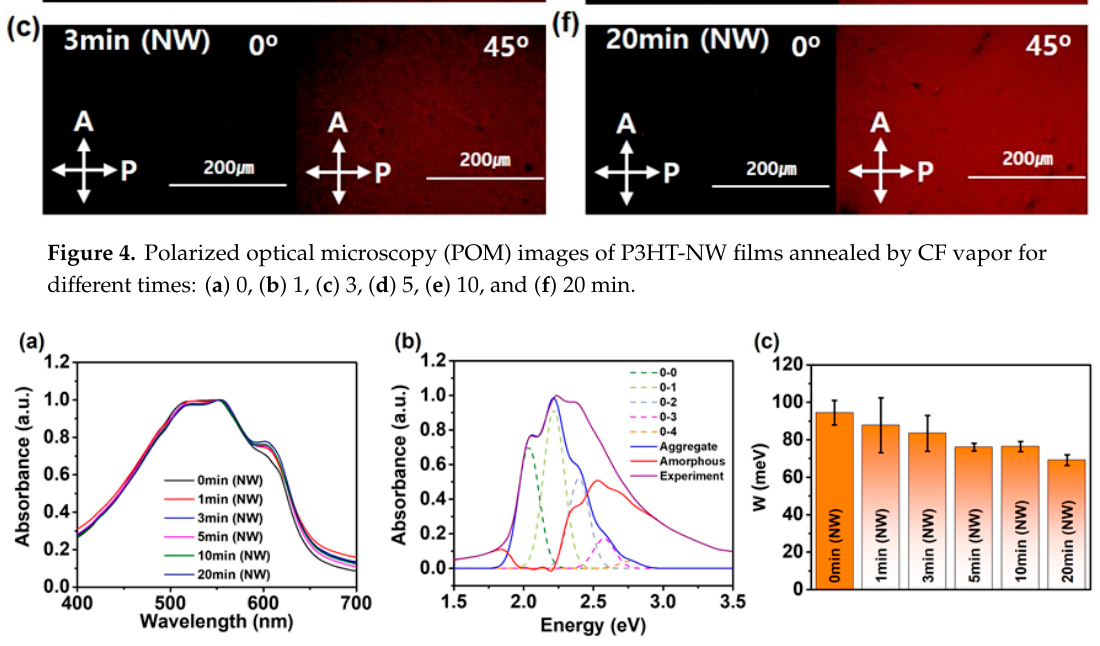
Figure 5. ( a ) Normalized UV–VIS absorption spectra of P3HT-NW films annealed with CF vapor for 1, 3, 5, 10, and 20 min. ( b ) Absorption spectrum of P3HT-NW films annealed with CF vapor for 20 min deconvoluted by Spano analysis using Equation (1). The red line indicates the spectrum of amorphous P3HT chains, and the blue line depicts the spectrum of P3HT aggregates in the film. ( c ) Calculated exciton bandwidth ( W ) of P3HT-NW-film CF vapor annealed for various times.